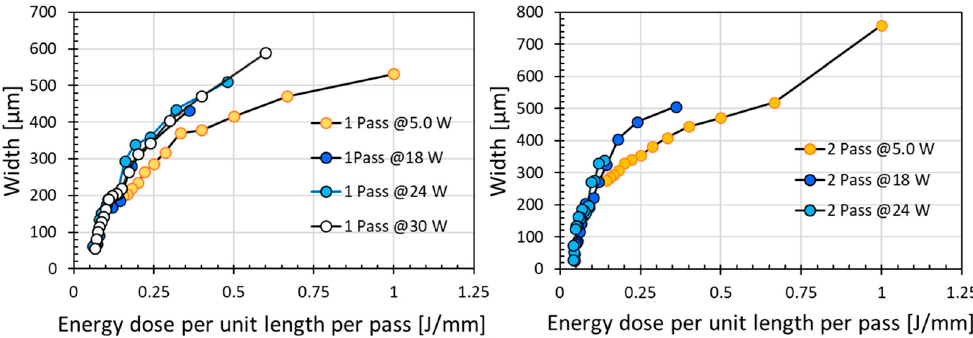
Figure 7. Scanning line width under various energy dose per unit length per pass for one or two passes (power of 5, 18, 24, and 30 W gave density of 3.44, 12.40, 16.54, and 20.67 W/cm 2 , respectively).